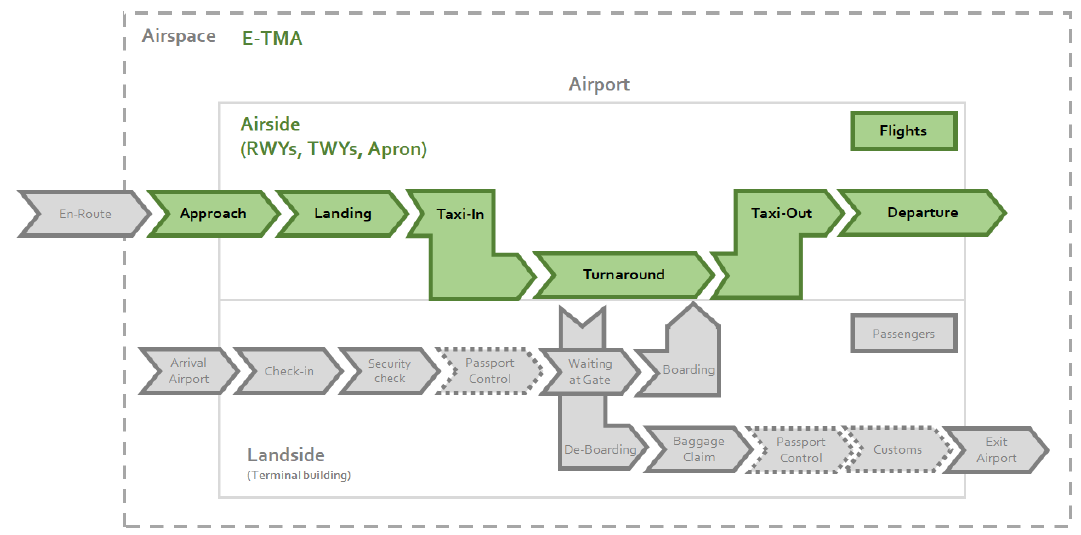
Figure 2. Spatial scope of the problem (airspace/airside operations).